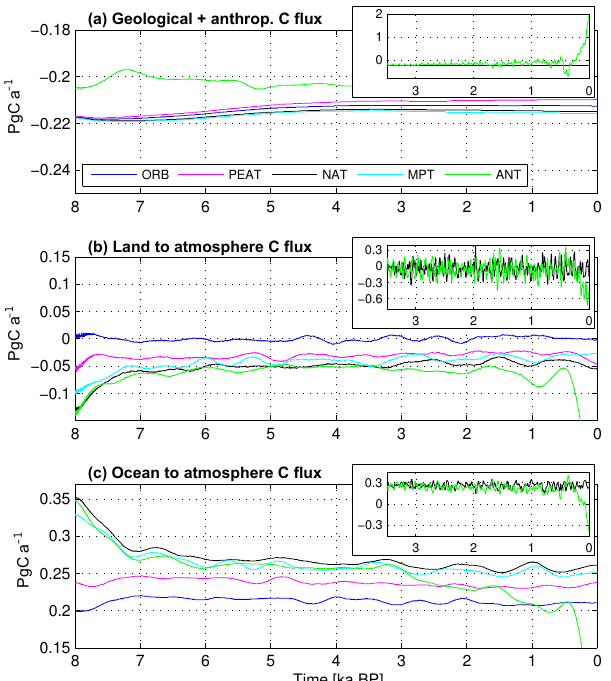
Figure 3. Disaggregation of the net carbon fluxes in the Holocene experiments: geological and anthropogenic flux to atmosphere (a) , land–atmosphere flux (b) and ocean–atmosphere flux (c) . Plots have been smoothed using a 1000-year Gaussian filter for clarity. Inset figures show fluxes from HOL_ANT and HOL_NAT with axis scal- ing appropriate for HOL_ANT and smoothed using a 50-year Gaus- sian filter.